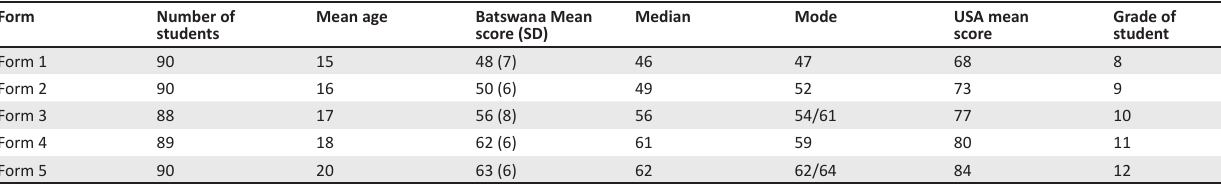
TABLE 1: The 1976 results of Reading for Understanding placement test.